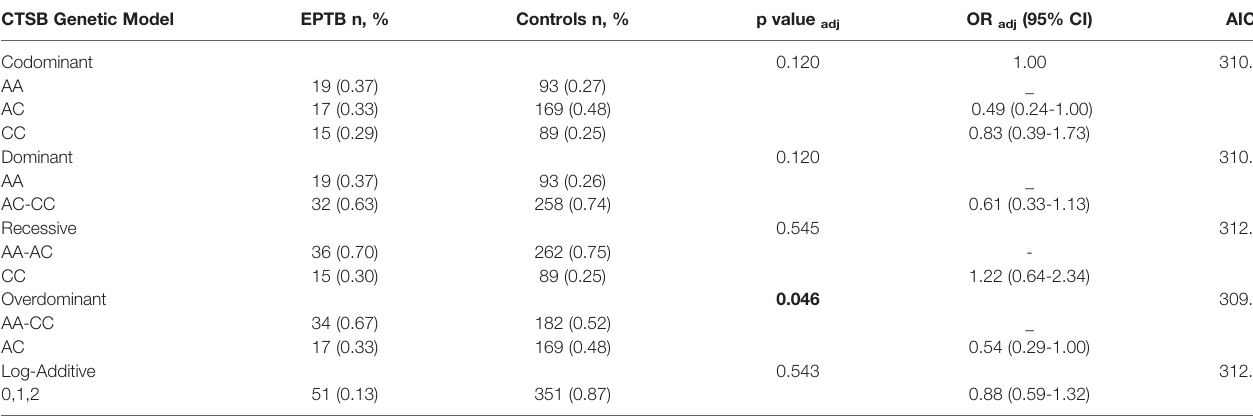
TABLE 3 | Genetic models of association SNV rs1692816 of CTSB gene adjusted for sex and age in patients with extrapulmonary tuberculosis (EPTB) and healthy control subjects. CTSB Genetic Model